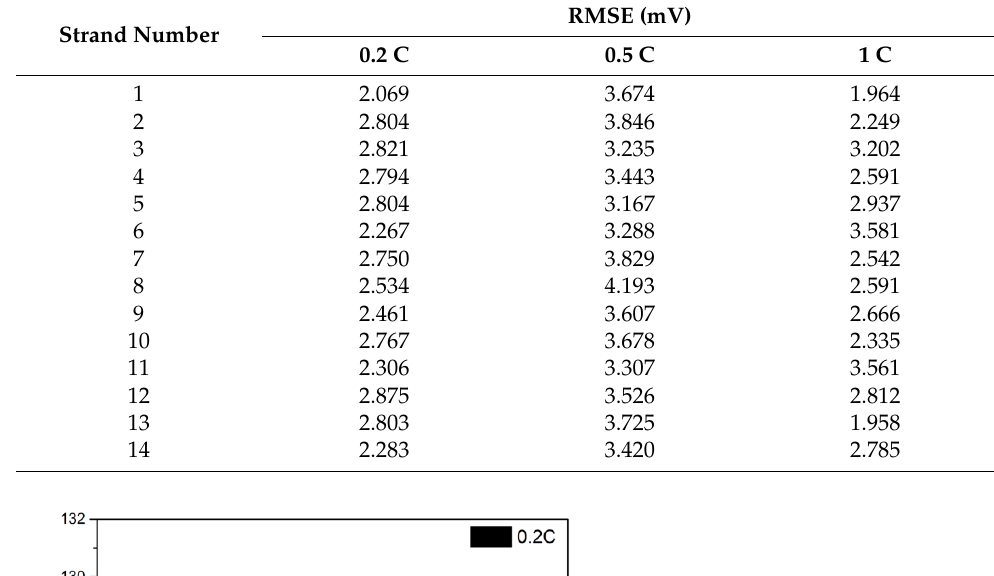
Table 1. RMSE of the modeling results and experimental data of discharge voltages of LIB strands at 0.2 C, 0.5 C, and 1 C. Strand